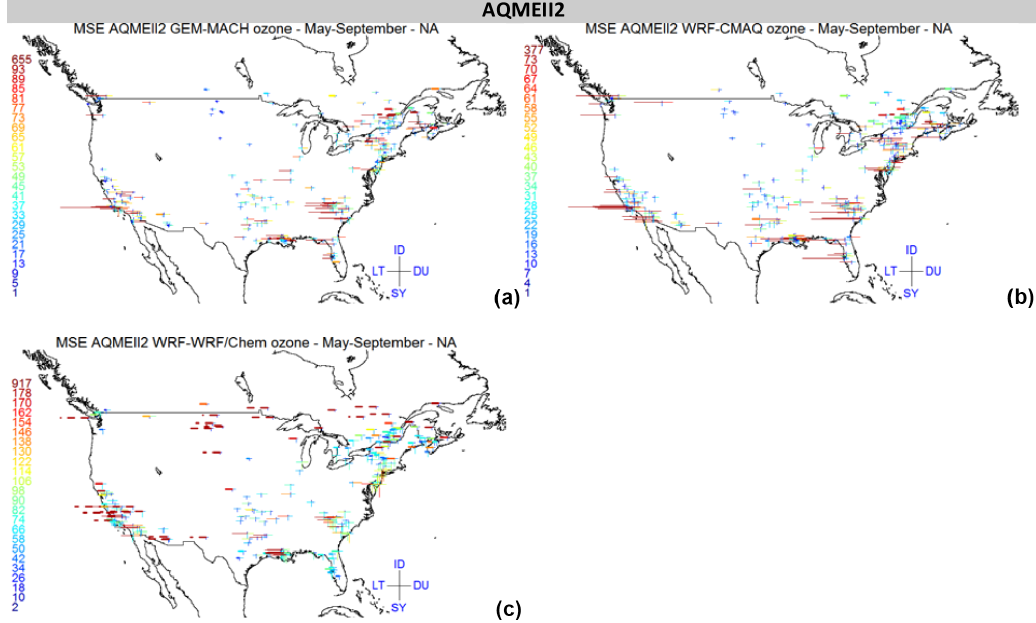
Figure 6. As in Fig. 3, but for the NA models of